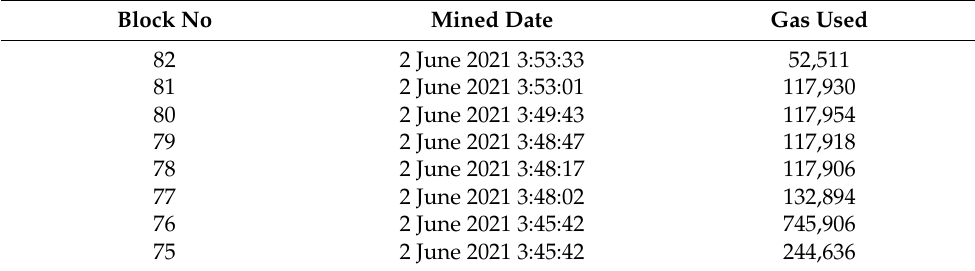
Table 1. Gas used for every